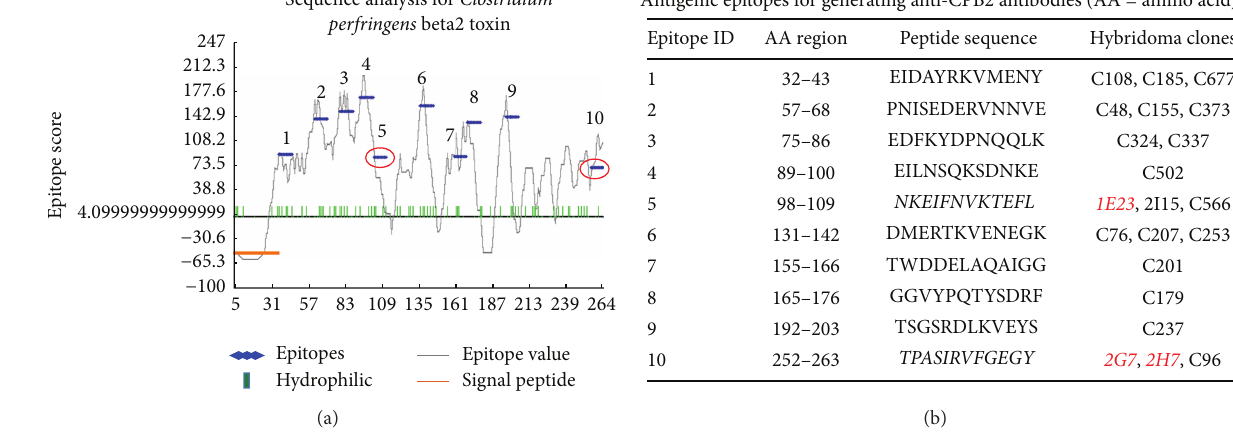
Figure 4: Generation of hybridoma cell lines producing antibodies against CPB. Ten predicted antigenic epitopes were used for generation and screening of antibodies against CPB2 using a SEAL technology (Surface Epitope Antibody Library) developed by Abmart (Shanghai, China). (a) A graph showed an overall structure of protein of interest and the 10 epitopes selected peptide for immunization to generate hybridoma cell lines producing specific antibodies against CPB2. The value of 𝑋 -axis indicated locations of amino acids (AAs) from N- terminal to C-terminal of CPB2 protein; the value of 𝑌 -axis indicated scores of algorithm, a high score represented an epitope with high possibility. The ten selected epitopes (1–10) were highlighted with blue on the graph. The epitopes 5 and 10 were circled in red, and antibodies to epitopes 5 and 10 were further identified to react with rCPB2 in this study. (b) The IDs, AA regions, AA sequence, and hybridoma cell clones of respective epitopes examined in this study. The peptide sequences in italic were able to generate cell clones producing antibodies that were identified to react with rCPB2 (clones 1E23, 2G7, and 2H7, labeled in red and